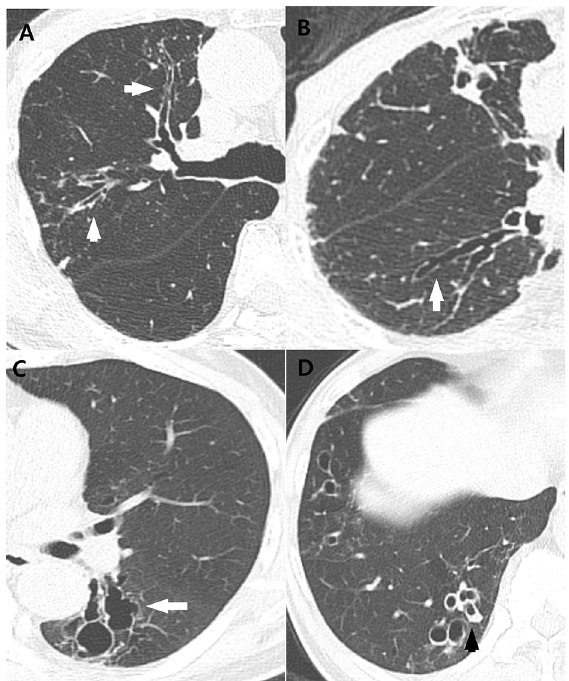
Fig 2. Examples of bronchiectasis to CT scoring of MAC lung disease. (A) Mild bronchiectasis in anterior and posterior segments of right upper lobe of 67-year-old man, scored as 1 point, with bronchusdiameter greater than adjacent vessel diameter(arrows). (B) Moderate bronchiectasis in superiorsegment of right lower lobe of 86-year-old woman, scored as 2 points, with bronchus diametertwo to three times vessel diameter(arrow). (C) Severe bronchiectasis in superiorsegment of left lower lobe of 66-year-old man, scored as 3 points, with bronchusdiameter greater than three times vessel diameter(arrow). (D) Mucus plugging associated with severe bronchiectasis in posterior basal segment of right lower lobe of 66-year-old man (arrow).